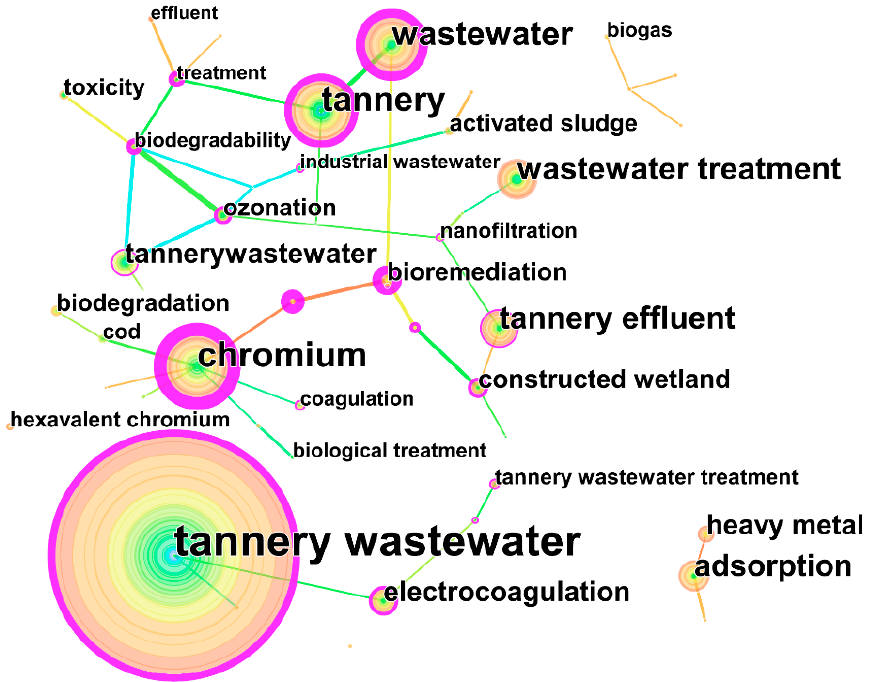
Figure 6. Keyword co-occurrence map of tannery wastewater research. It demonstrates that “tannery wastewater”, “chromium” and “tannery” are often used terms in tannery wastewater studies (228, 77 and 67). Because “tannery wastewater” is the topic of this study, it is expected that it ranks #1 in frequency. There are other keywords such as “wastewater treatment”, “adsorption” and “electrocoagulation” that are popular topics in tannery wastewater